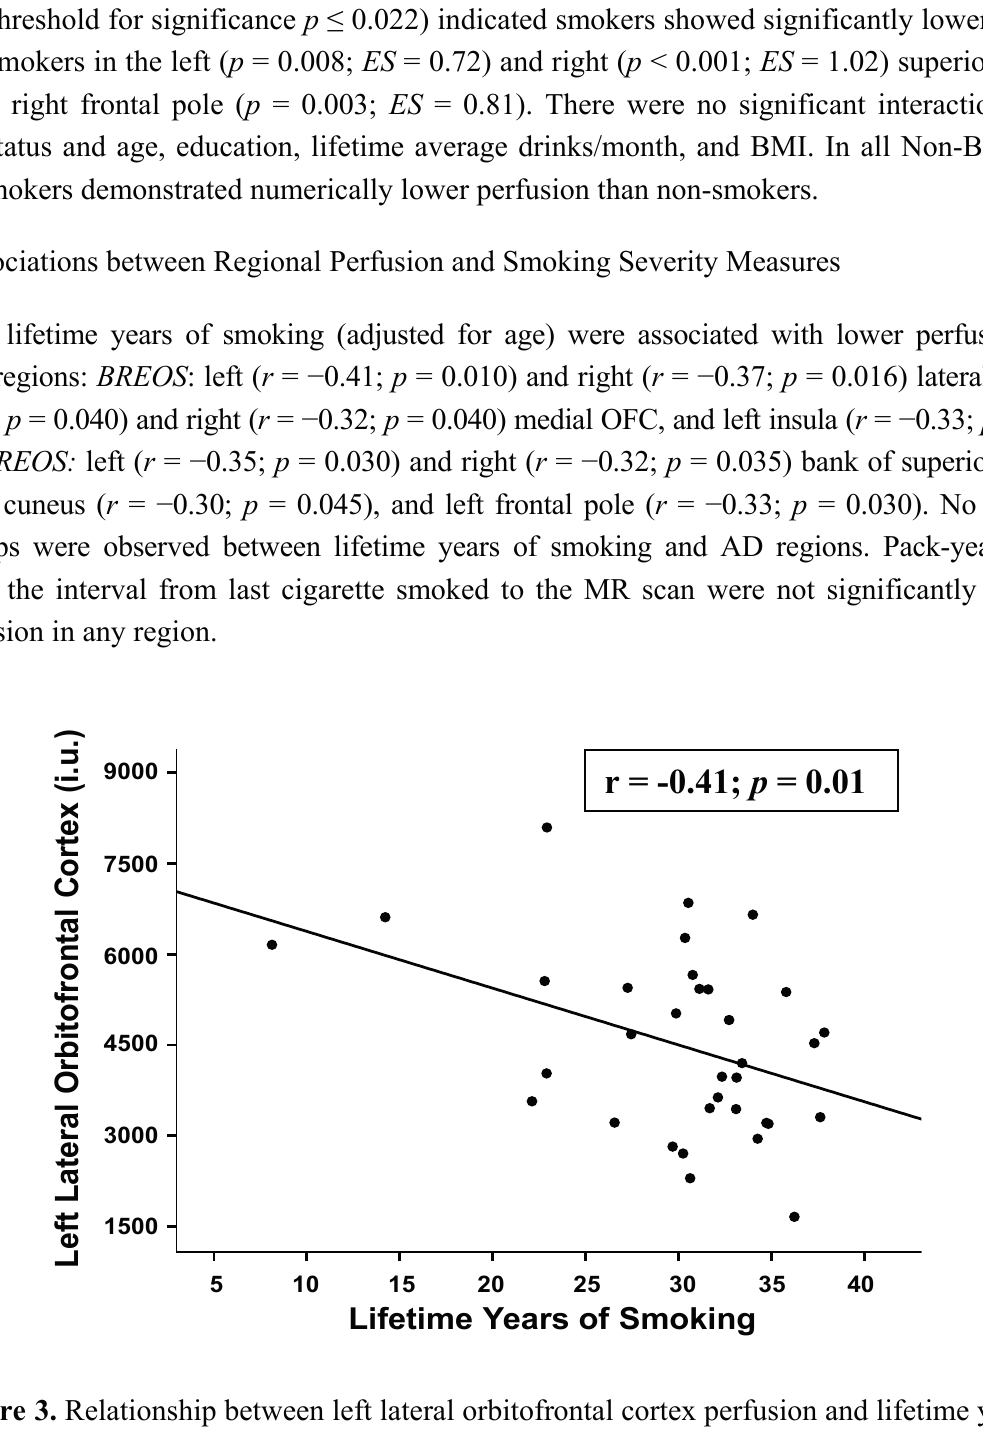
Figure 3. Relationship between left lateral orbitofrontal cortex perfusion and lifetime years of smoking